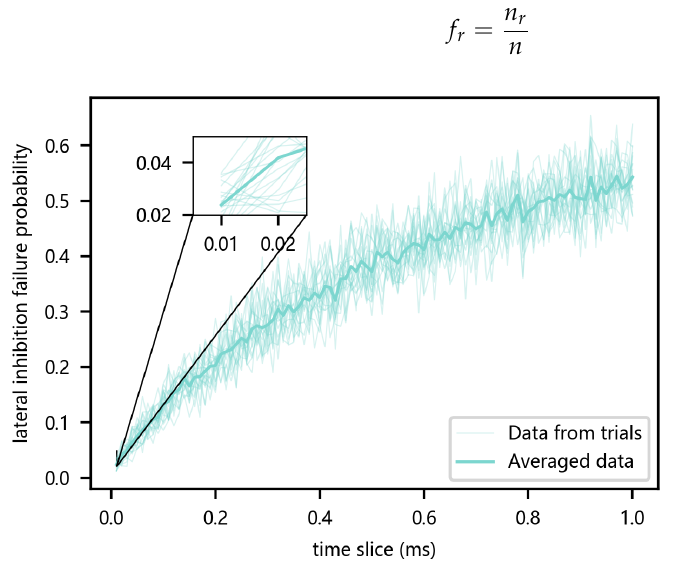
Figure 3. Influence of time slice length on failure probability of lateral inhibition in